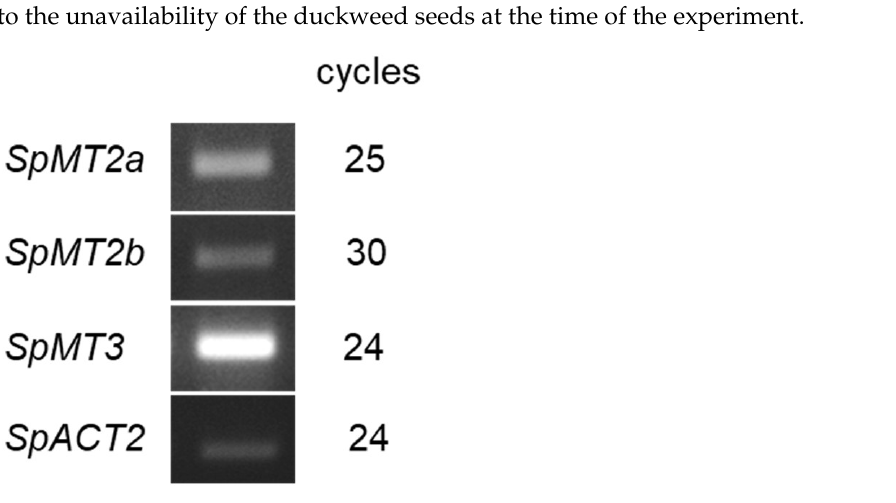
Figure 2. Semi-quantitative RT-PCR analysis of transcript abundance in the whole plant tissues of Figure 2. Semi - quantitative RT - PCR analysis of transcript abundance in the whole plant tissues of S . S . polyrhiza cultured in normal Hoagland solution. SpACT2 was included as a standard control. The polyrhiza cultured in normal Hoagland solution . SpACT2 was included as a standard control . The number of cycles used in the PCR reactions are number of cycles used in the PCR reactions are indicated .